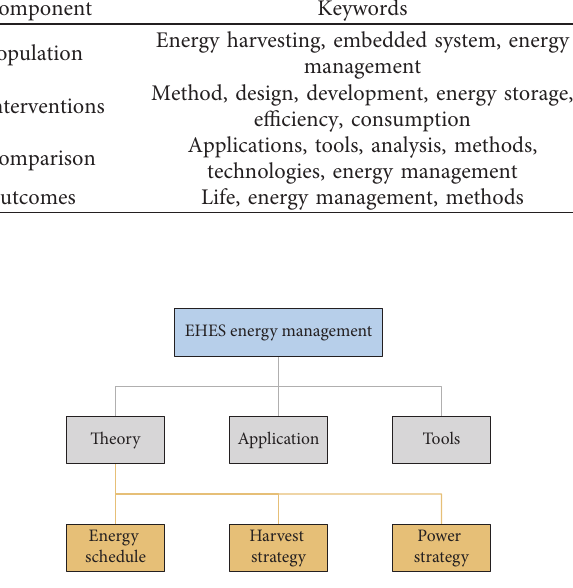
Table 3: Extracted keywords from the PICO model. Component